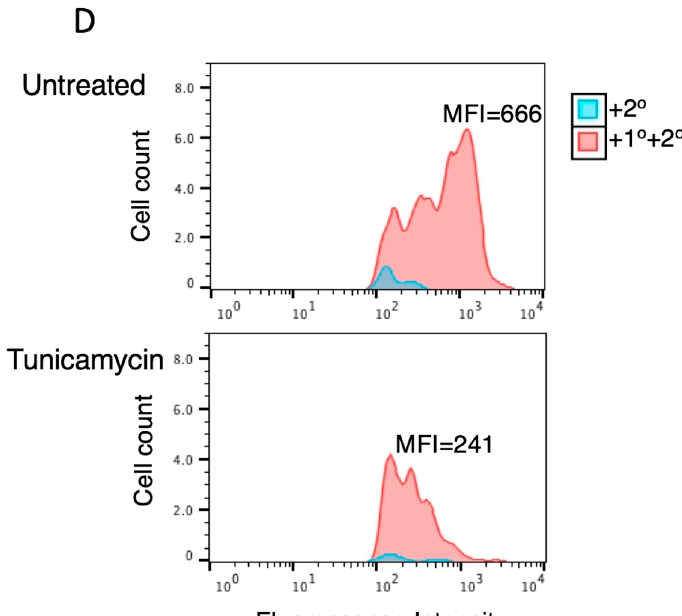
Figure 5. High-mannose glycosylation of a single Asn is sufficient for cell-surface expression of tetherin. ( A ) 293T cells were transfected with the delVpu HIV-1 molecular clone, and vectors expressing HA-tagged WT or glycosylation-defective tetherin mutants (N65A, N92A, and N65,92A). Eight hours post transfection, cells were untreated or treated with 10 µ M kifunensine as in Figure 3A, and cell and viral lysates were collected and subjected to western blot analysis with HIV-Ig, or anti-HA antisera as in Figure 1A. “}” indicates the position of complex-glycosylated tetherin. * denotes putative dimeric tetherin; ( B ) Virus release efficiency (VRE) was calculated as in Figure 1B; VRE in the absence of tetherin and without kifunensine treatment was set to 100%. Data shown are ± SD from three independent experiments; ( C ) 293T cells were transfected with vectors expressing HA-tagged WT or glycosylation-defective tetherin mutants (N65A, N92A, and N65,92A) and 0.1 µ g of a GFP expression vector. Eight hours post transfection, cells were untreated or treated with kifunensine for 24 h, washed, harvested, and stained with anti-HA primary antibody and Alexa Fluor 594-conjugated secondary antibody and processed for flow cytometry as in Figure 2A; ( D ) 293T cells were transfected with 0.8 µ g HA-tagged WT tetherin expression vector and 0.1 µ g of GFP expression vector. Eight hours post transfection, cells were untreated or treated with 1 µ g/mL tunicamycin. One day later, cells were processed and cell-surface expression was monitored by flow cytometry as in Figure 2A; ( C , D ) the y -axis represents the number of events (cell count). MFI, mean fluorescence intensity. Representative flow cytometry histograms from three ( C ) or two ( D ) independent experiments are shown.